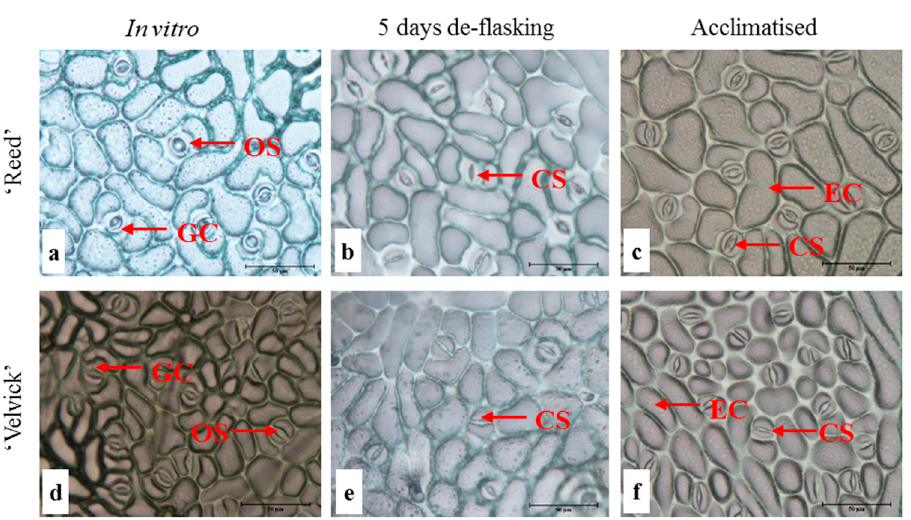
Figure 4. Stomates under in vitro conditions appear to be fully open compared to the de-flasked and acclimated stages in both rootstocks ‘Reed’ and ‘Velvick’. Lower epidermis of the 3 rd fully expanded leaf of in vitro cultured plantlets of ‘Reed’ ( a – c ) and ‘Velvick’ ( d – f ) at different stages, in vitro shoot before rooting ( a , d ), 5 days after de-flasking in water before acclimation ( b , e ) and 1 month in acclimation ( c , f ) were sampled ( n = 5). OS = open stomates, CS = closed stomates GC = guard cells, EC = epidermal cells.